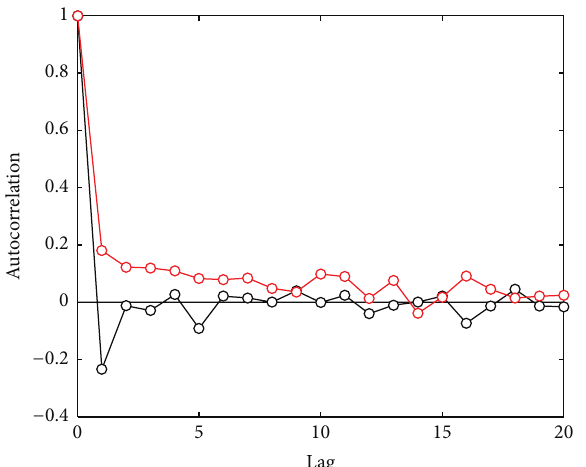
Figure 6: Autocorrelation function of the simulated stock 3. The black line shows the autocorrelation function of the returns. The red line is the autocorrelation of the absolute returns.